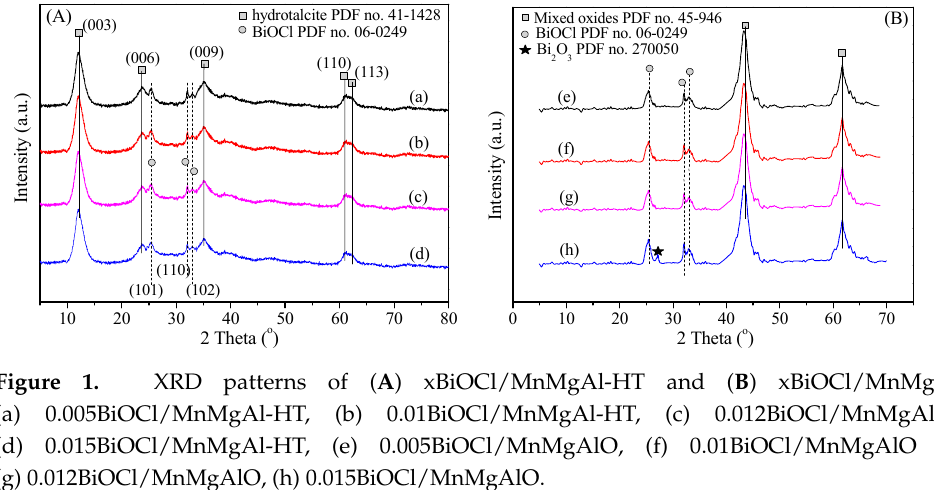
Figure 1. XRD patterns of ( A ) xBiOCl/MnMgAl-HT and ( B ) xBiOCl/MnMgAlO (a) 0.005BiOCl/MnMgAl-HT, (b) 0.01BiOCl/MnMgAl-HT, (c) 0.012BiOCl/MnMgAl-HT, (d) 0.015BiOCl/MnMgAl-HT, (e) 0.005BiOCl/MnMgAlO, (f) 0.01BiOCl/MnMgAlO and